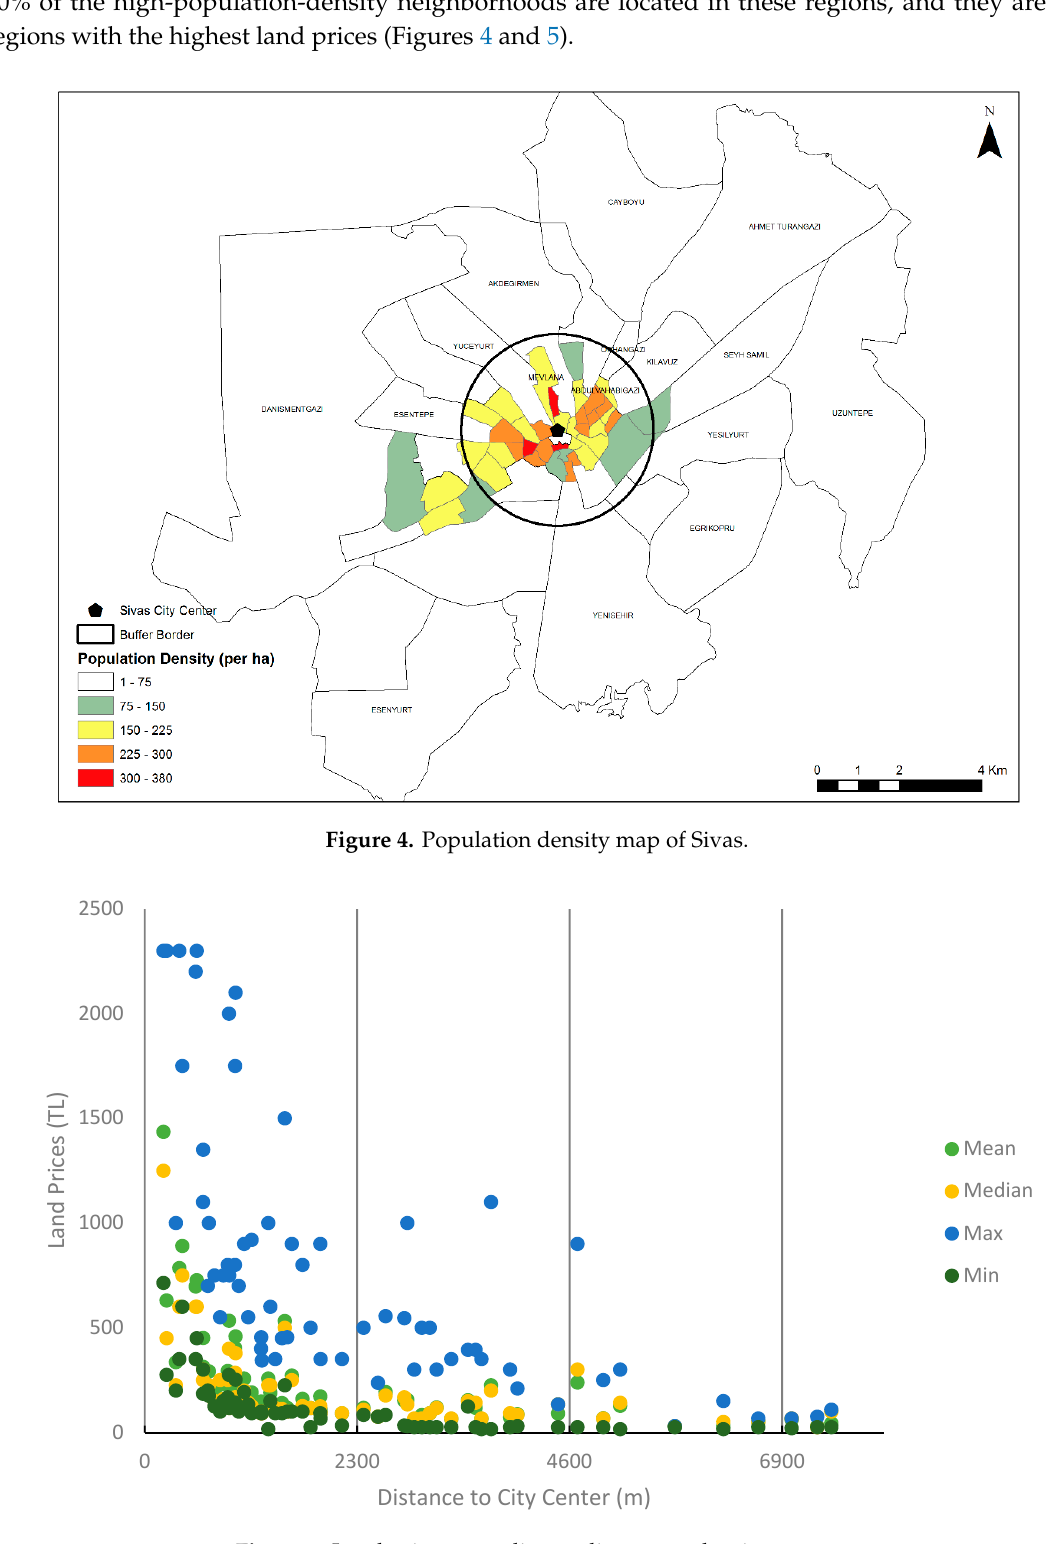
Figure 5. Land prices according to distance to the city center.